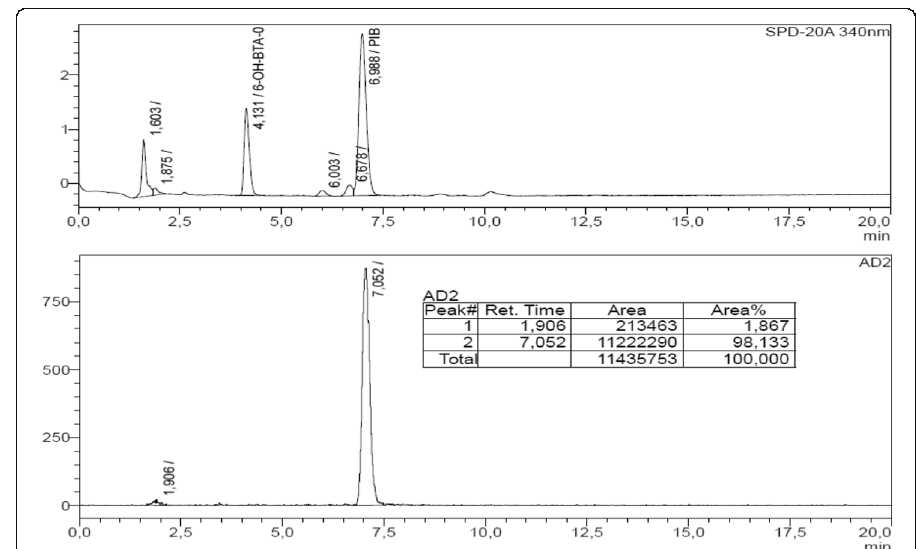
Fig. 3 Analytical radio-HPLC for formulated [ 11 C]PiB: upper: UV (340 nm); lower: gamma